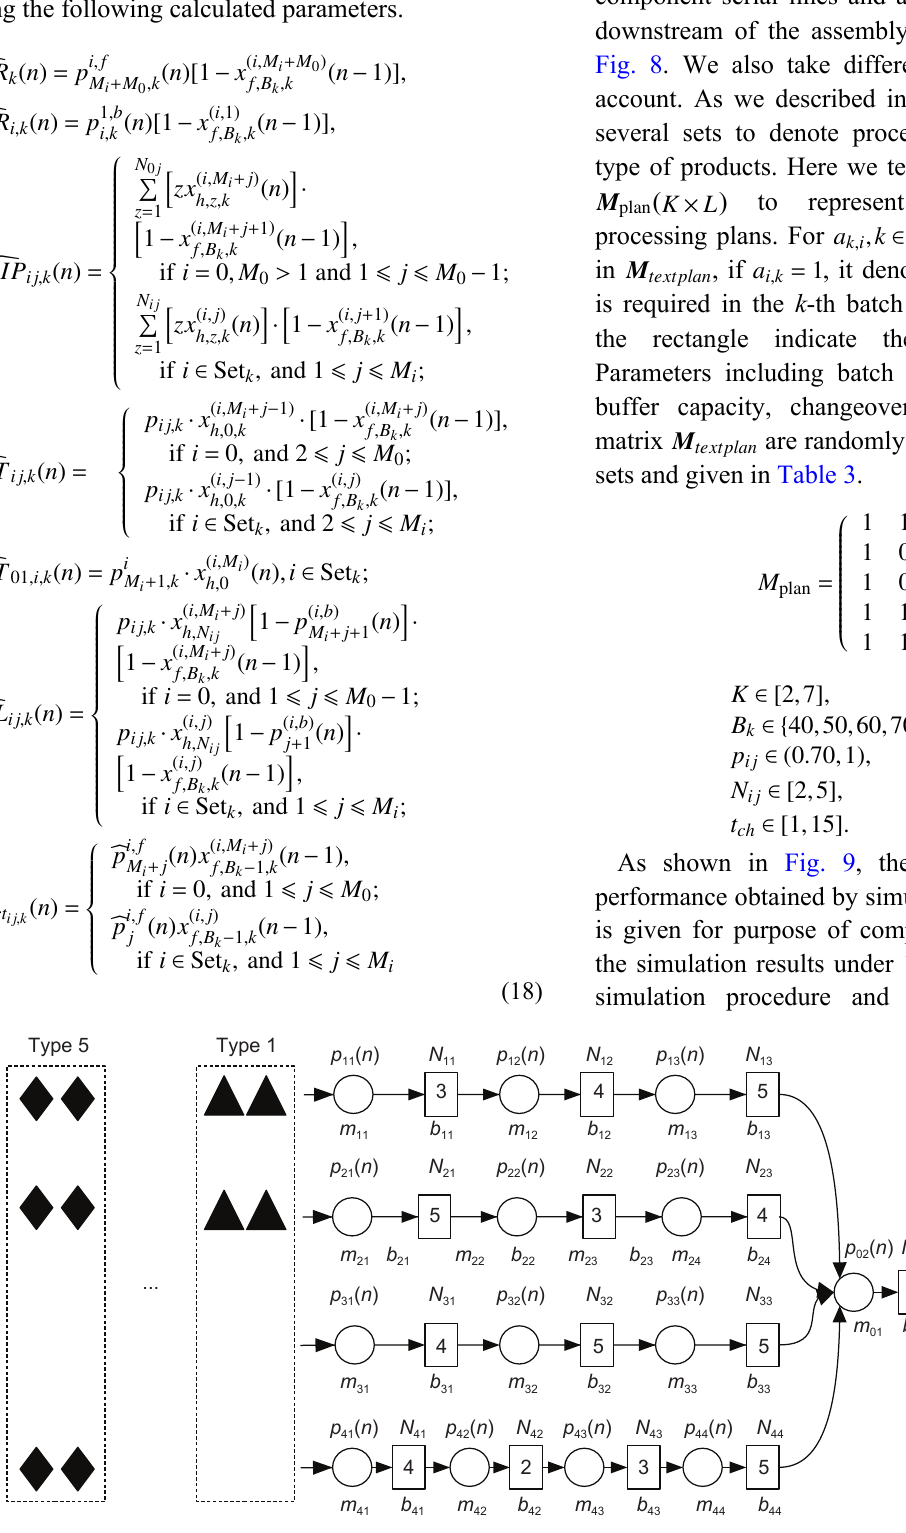
Fig. 8 An illustrative assembly system with two component lines and two additional machines after the assembly